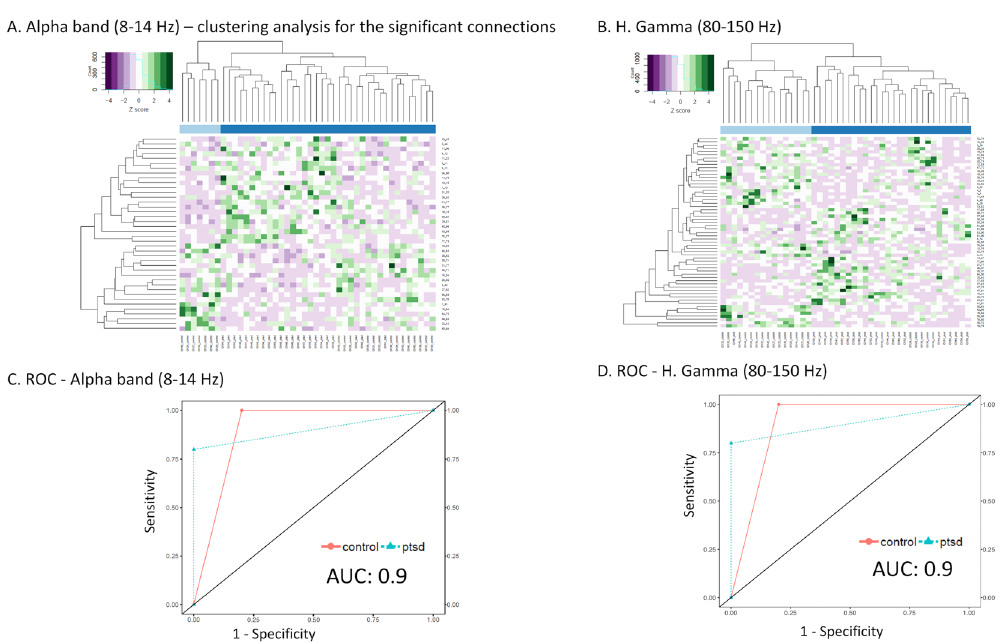
Figure 3. Heatmaps for hierarchical clustering analysis results using only the significant edges (p < 0.01) as well as ROC-AUC results for the Alpha and H. Gamma bands. For heatmaps, dendrograms show the clusters for participants (columns) and the edges (rows), and z score was plotted. For ROC, AUC values are shown on the plot. ( A ) Alpha band heatmap, ( B ) H. Gamma band heatmap, ( C ) Alpha band ROC, and ( D ) H. Gamma band